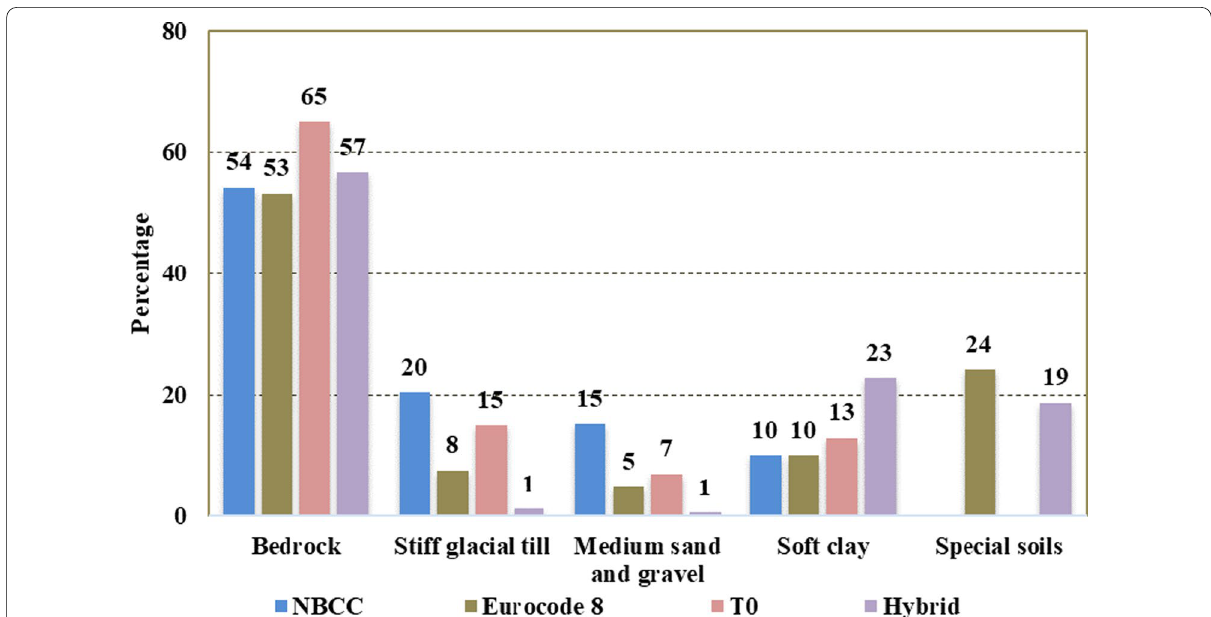
Fig. 5 Relative surface area coverage by each soil type based on the four site classification schemes: Eurocode 8, NBCC, the fundamental site period and the hybrid